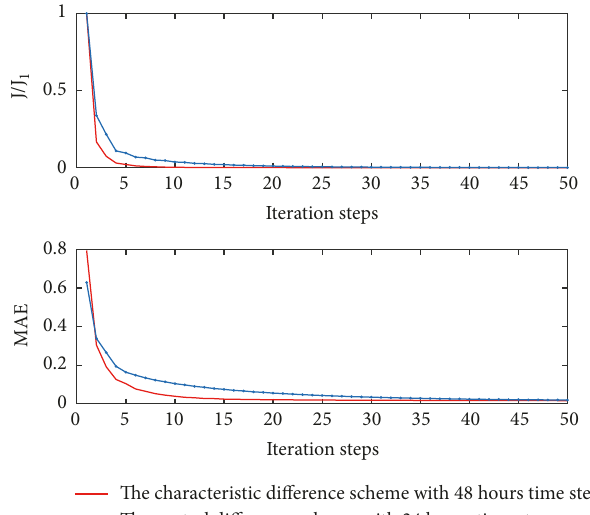
Figure 10: The descending curves of the relative magnitude of the cost function 𝐽/𝐽 1 and the mean absolute error (MAE) of observation points using CFD and CDS with different time